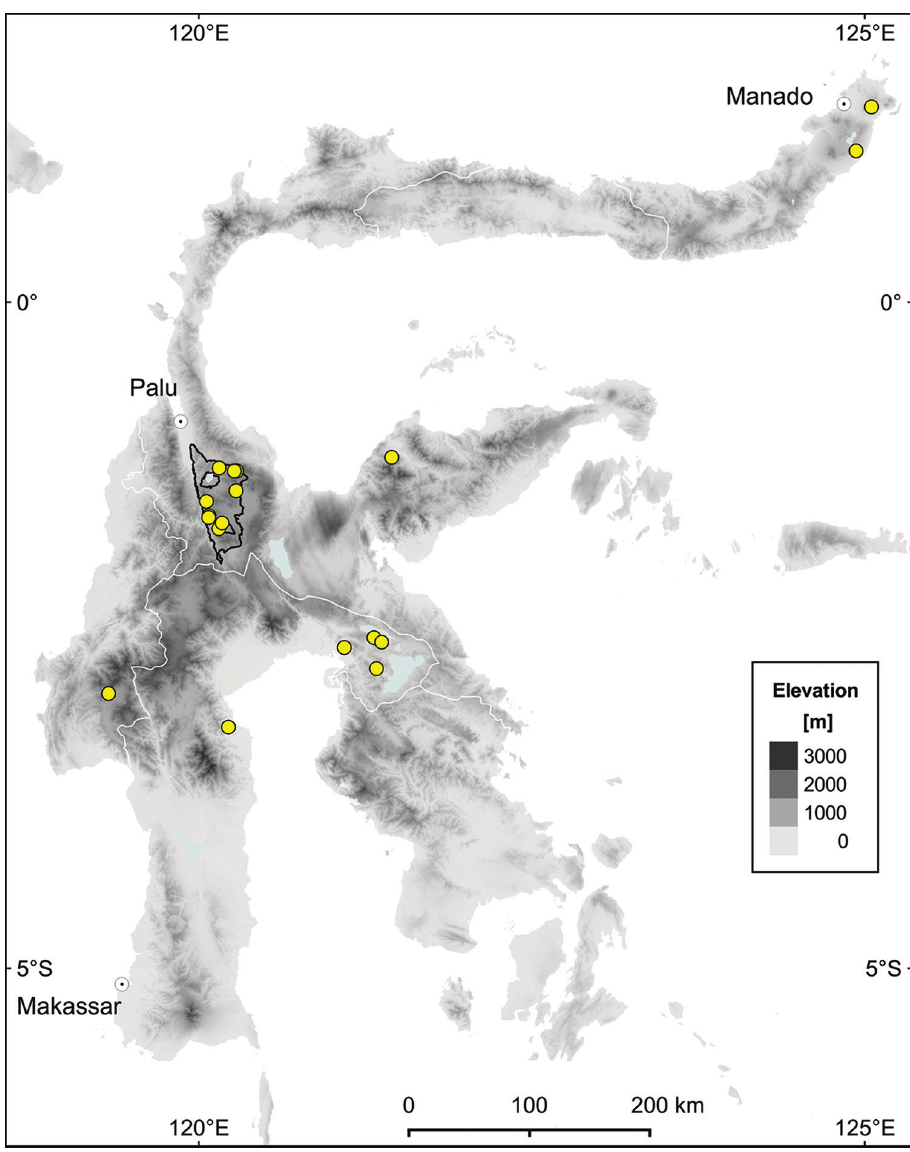
Figure 2. Distribution map of Syzygium balgooyi in Sulawesi. Collecting localities are shown as yellow dots; Lore Lindu National Park is indicated by a black line. Map created with QGIS (QGIS Development Team 2016) using the digital elevation model of Jarvis et al.